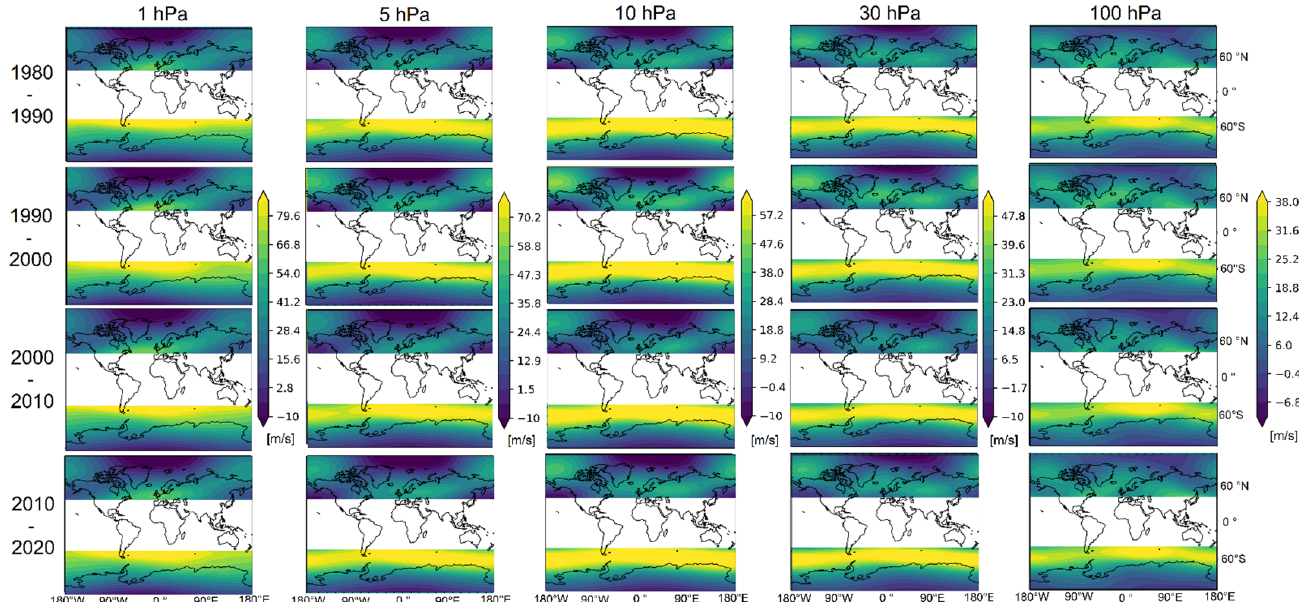
Figure 6. Zonal wind climatology (m/s, blue means westerly, yellow easterly wind) for 1980–1990, 1990–2000, 2000–2010 and 2010–2020 using ERA5 reanalysis at 1, 5, 10, 30 and 100 hPa.